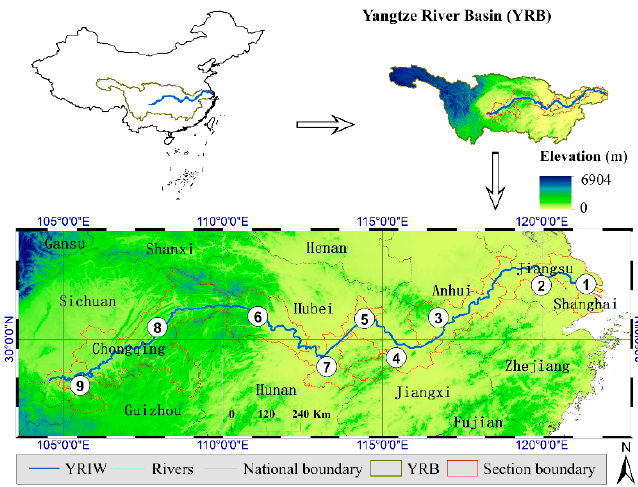
Figure 1. Map of the study area.